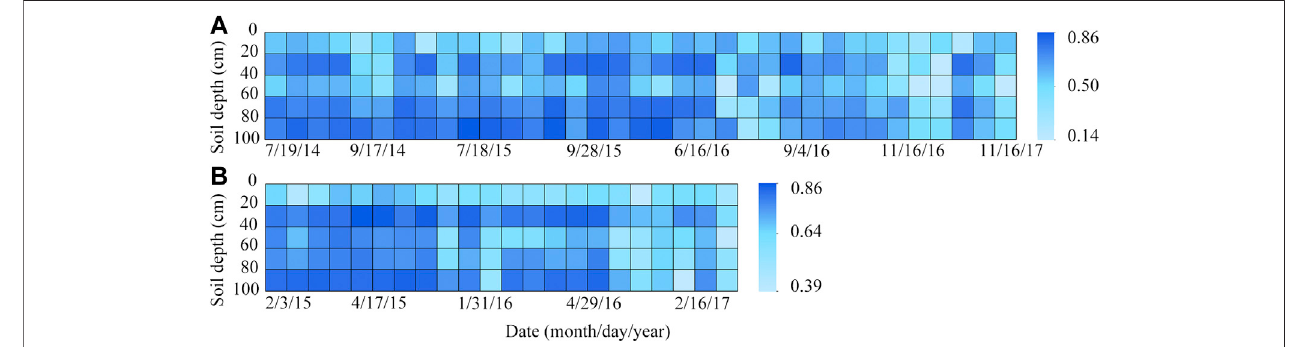
FIGURE 4 | Time series of mean Spearman rank correlation coef fi cients ( r s ) at different depths in the (A) rainy season and (B) dry season.